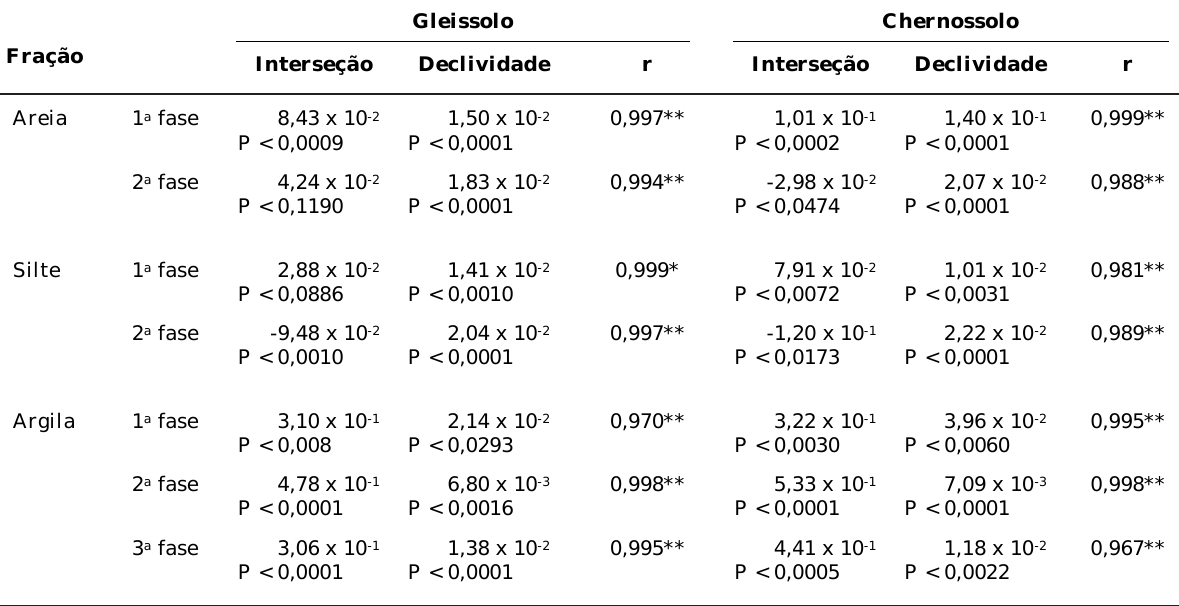
Quadro 4. Contribuição estimada das frações areia, silte e argila para o K-total liberado dos solos pela ação do ácido oxálico 0,01 mol L -1 , em 15 extrações seqüenciais, de 1 até 864 h de contato, totalizando um período de 3.409